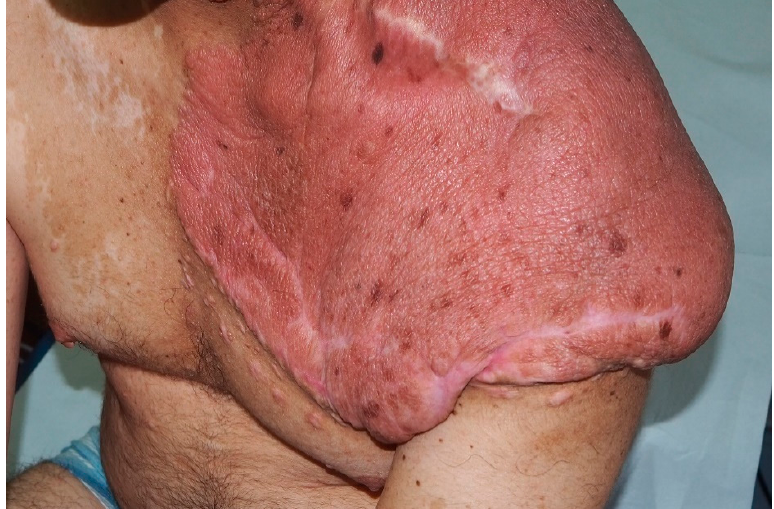
Figure 11. Large plexiform neurofibroma of the left shoulder. Blue red macules and pseudoatrophic macules are bizarre variants of cutaneous neu- rofibroma. If there is the predominance of wide vessels in neurofibromatous tissue located in papillary dermis, the lesion may appear as blue-red macules. Pseudoatrophic macules occur as a result of neurofibromatous tissue proliferation damaging collagen in reticular dermis. These two presentations are less frequent types of neurofibromas and they fulfill the diagnostic criterion of NF1 [33].